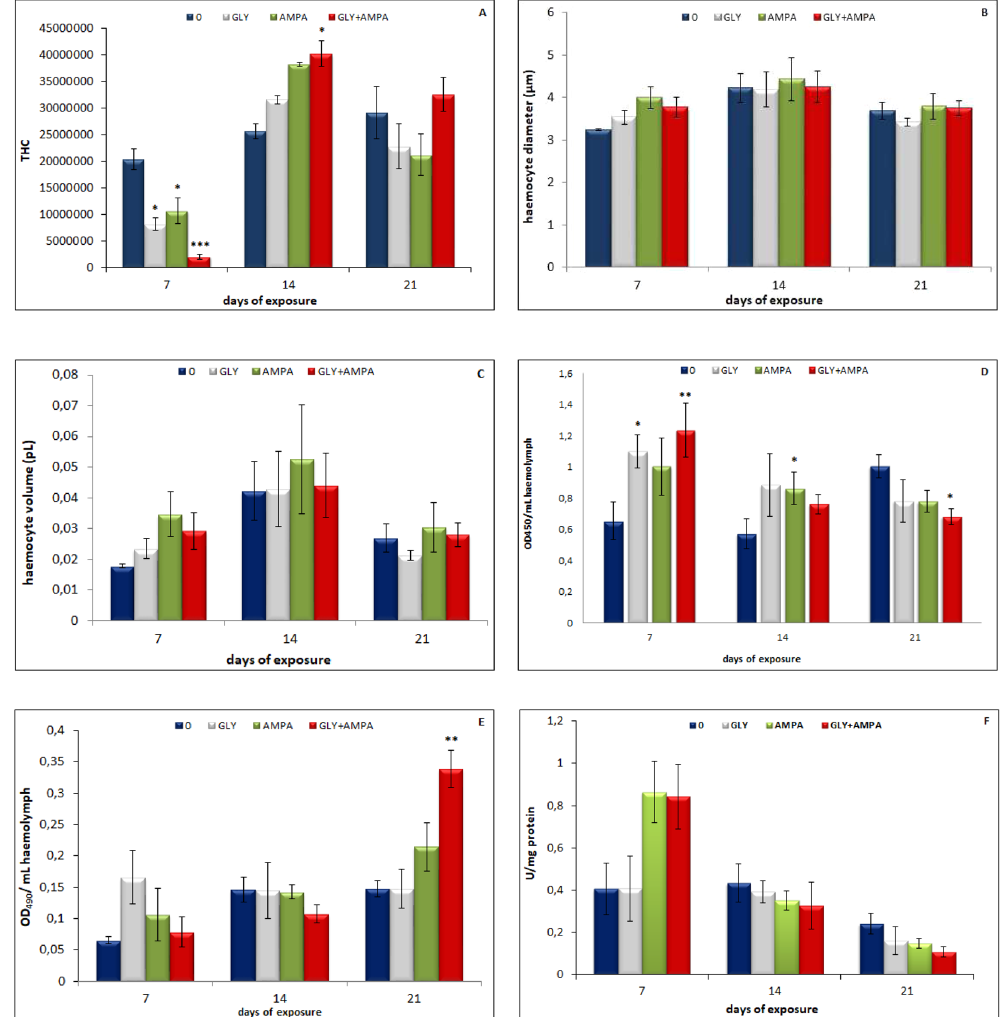
Figure 1. THC, expressed as the number of haemocytes/mL of haemolymph ( A ), haemocyte diameter, expressed in µ m ( B ), haemocyte volume, expressed in pL ( C ), haemocyte proliferation, expressed as OD/mL haemolymph ( D ), cell-free haemolymph lactate dehydrogenase activity, expressed as OD/mL haemolymph ( E ), and haemocyte lysate acid phosphatase activity, expressed as U/mg protein ( F ) of M . galloprovincialis exposed to glyphosate (GLY), AMPA and GLY + AMPA. The values are mean + SD (n = 5). The asterisks indicate significant differences in comparison with controls: * p < 0.05, ** p < 0.01, *** p <